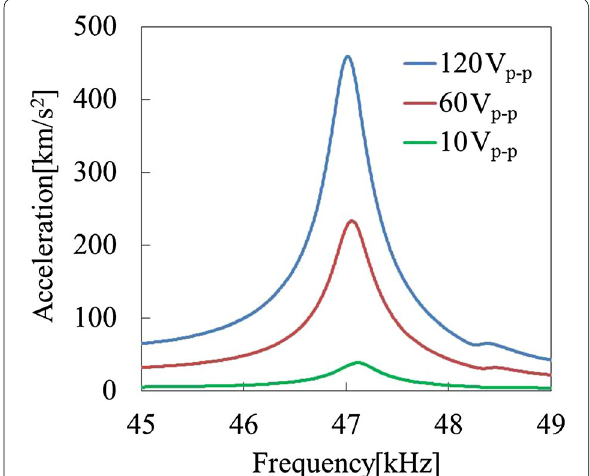
Fig. 11 Relationship between prototype’s acceleration and fre-